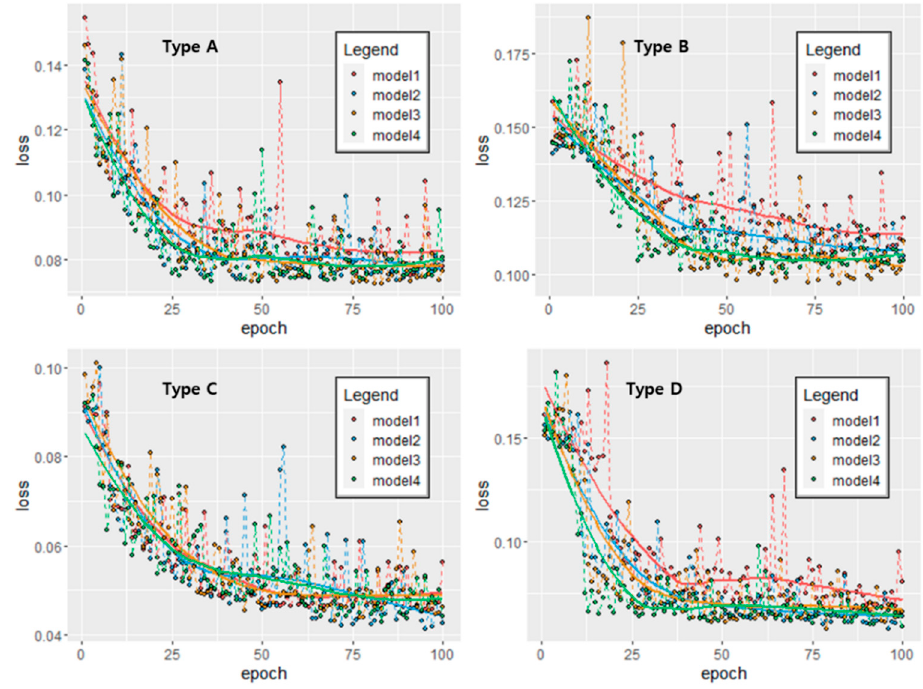
Figure 8. Loss graph for each type using the top four models.